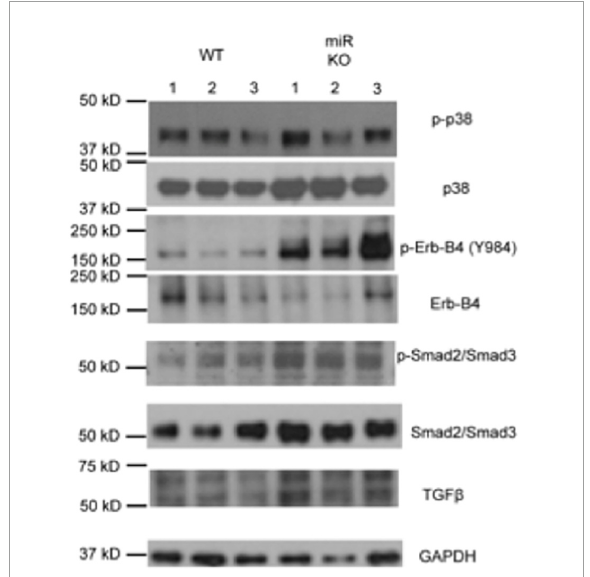
FIGURE7 Deletion of miR146a in podocytes upregulates ErbB4/TGF β /Smad3 signaling. Immunoblot analysis of various phosphorylated (p-) and total proteins in the lysates from primary podocytes isolated from the WT and Pod-miR146a mice. Data presented is from three independent samples from each group. GAPDH was used as the loading control. Relative position of the molecular weight markers is shown on the left.